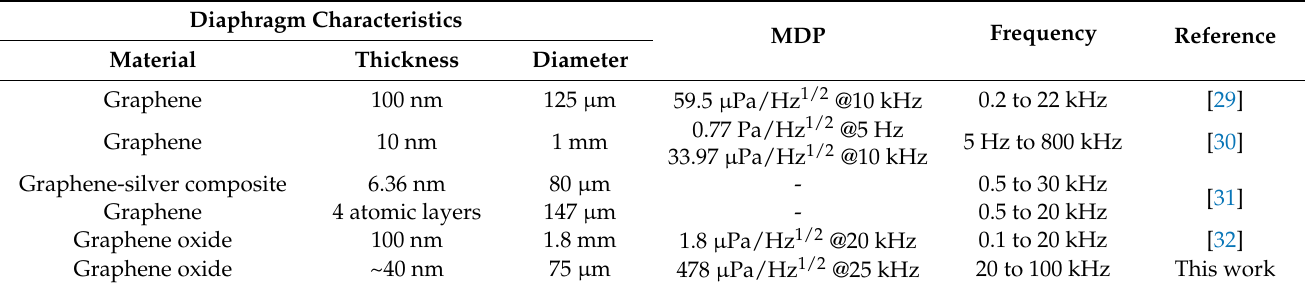
Table 1. Comparison of characteristics and performance between our sensor and similar sensor structures. Diaphragm